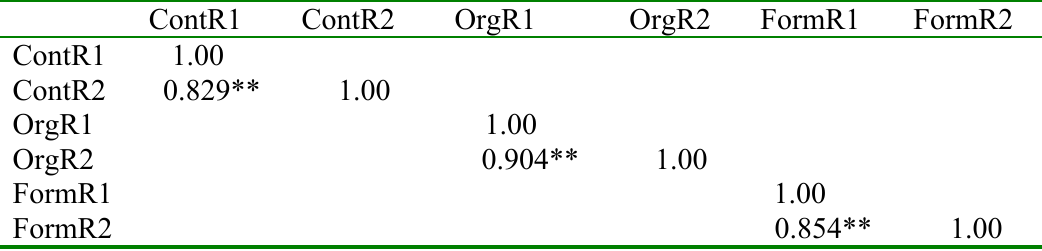
Correlation Matrix for the Writing Test, Spearman Rank-Order ( N =29)